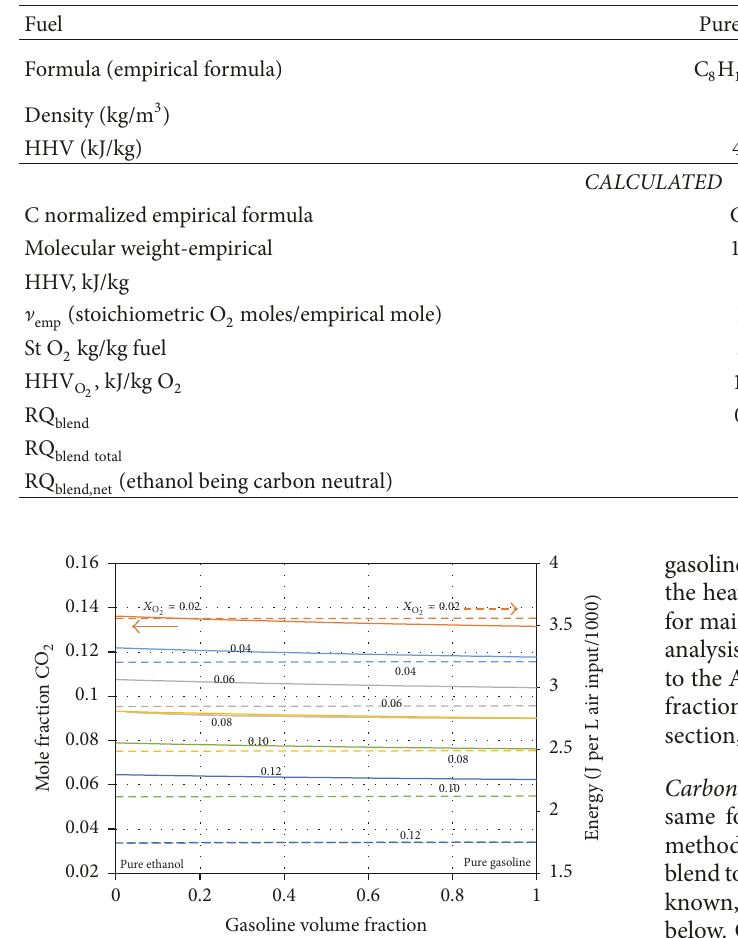
Table 6: RQ values for pure gasoline, pure ethanol, and for 85: 15 (vol%) gasoline: ethanol blend. Blend: volume%, gasoline: 85 and ethanol: 15; mass%, gasoline: 84.6 and ethanol: 15.4; heat%, gasoline: 90 and ethanol: 10; RQ